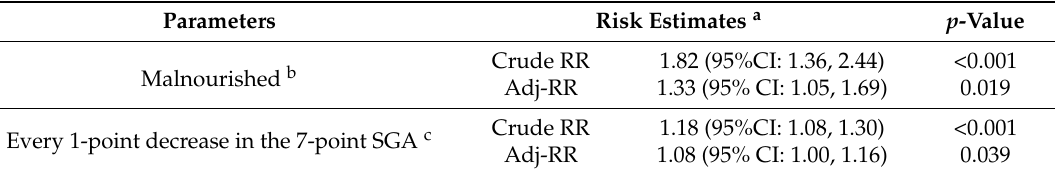
Table 2. Multivariable analysis of the association between malnutrition and 28-day mortality.